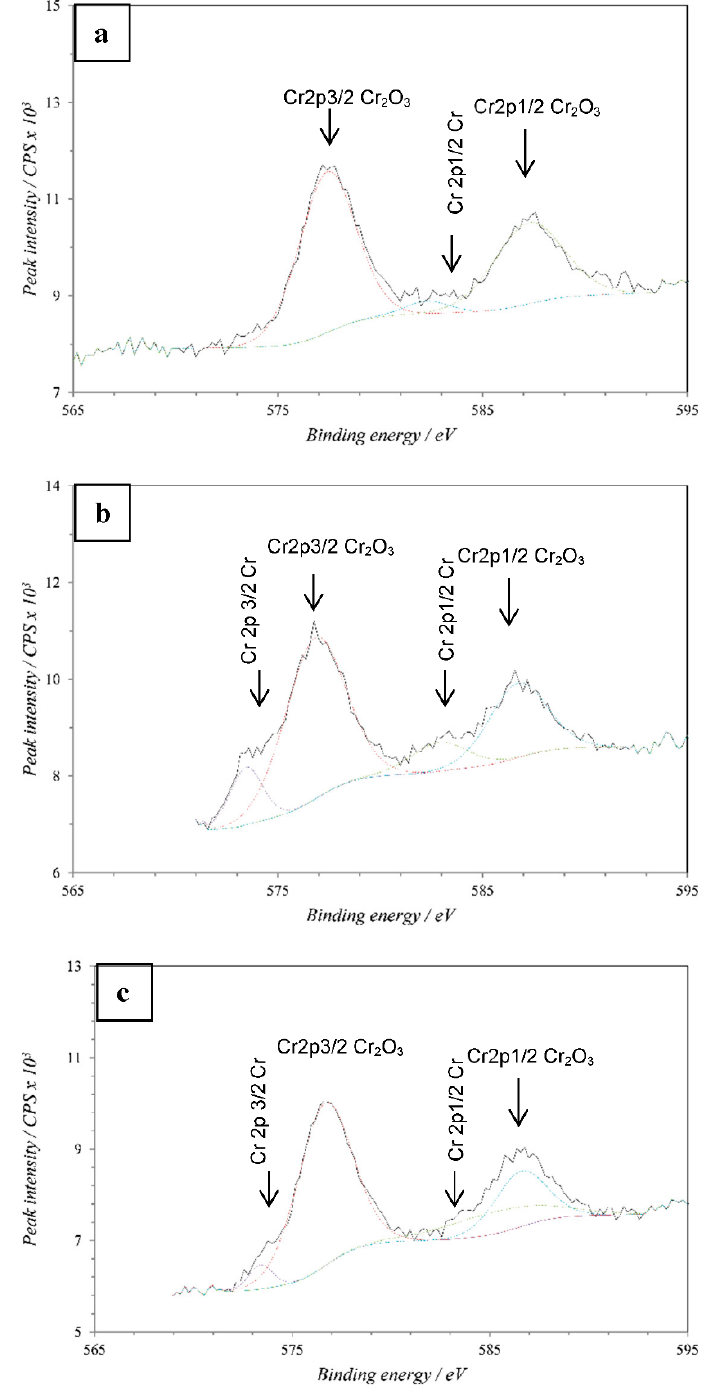
Figure 15. High resolution spectra of Cr 2p peaks, ( a ) sample exposed for 24 h, ( b ) sample polarized to 100 mV and ( c ) sample polarized to 1000 mV before polarization.